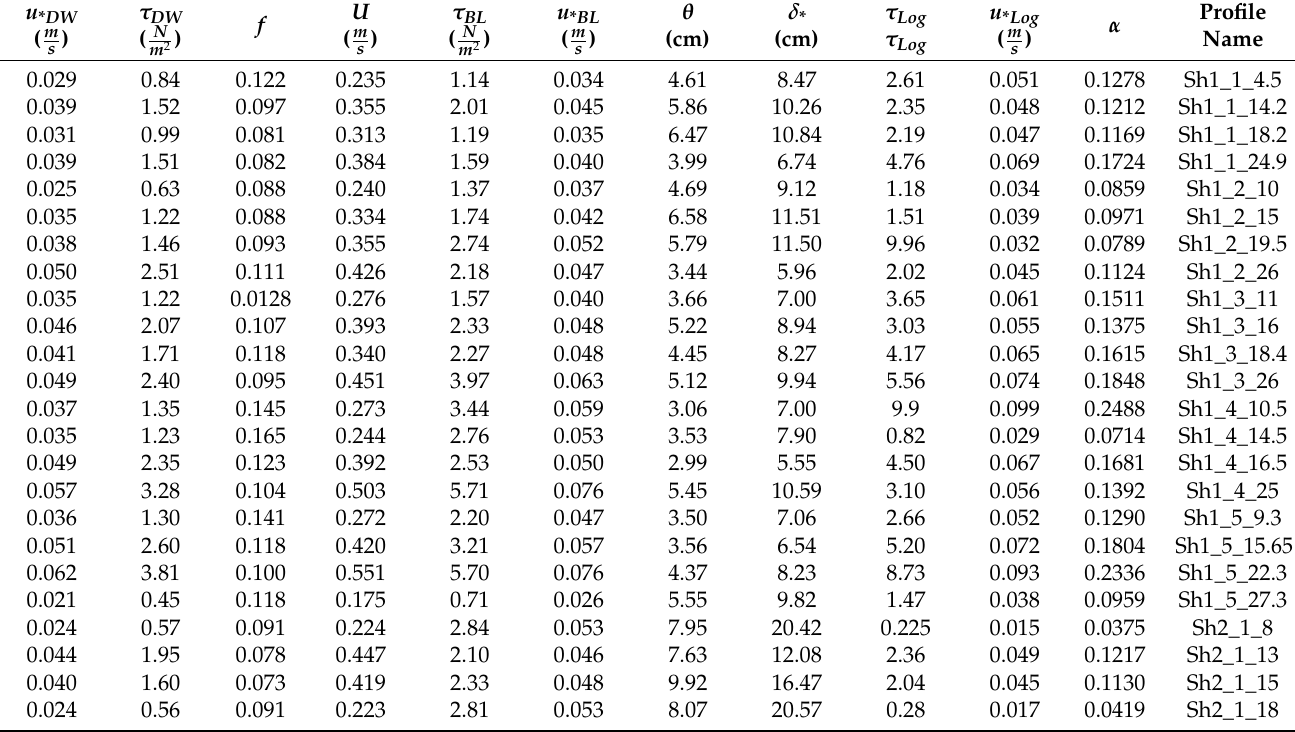
Table 6. Shear velocity and shear stress of the substrate calculated by different